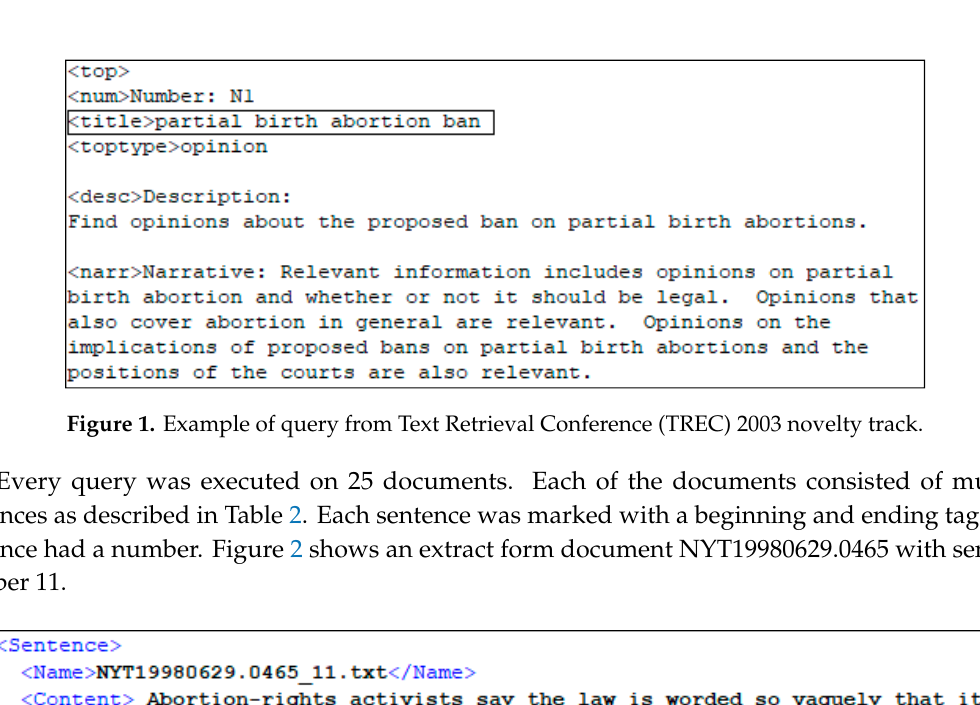
Table 2. Description of dataset characteristics. Name of the Collection